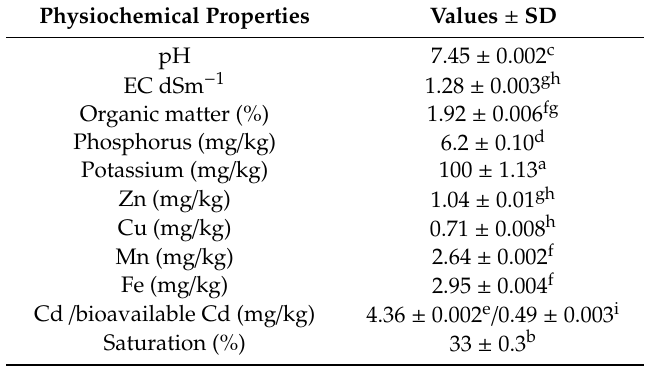
Table 1. Physiochemical properties of soil. Values are the means of three replicates. The values with ± show standard deviation